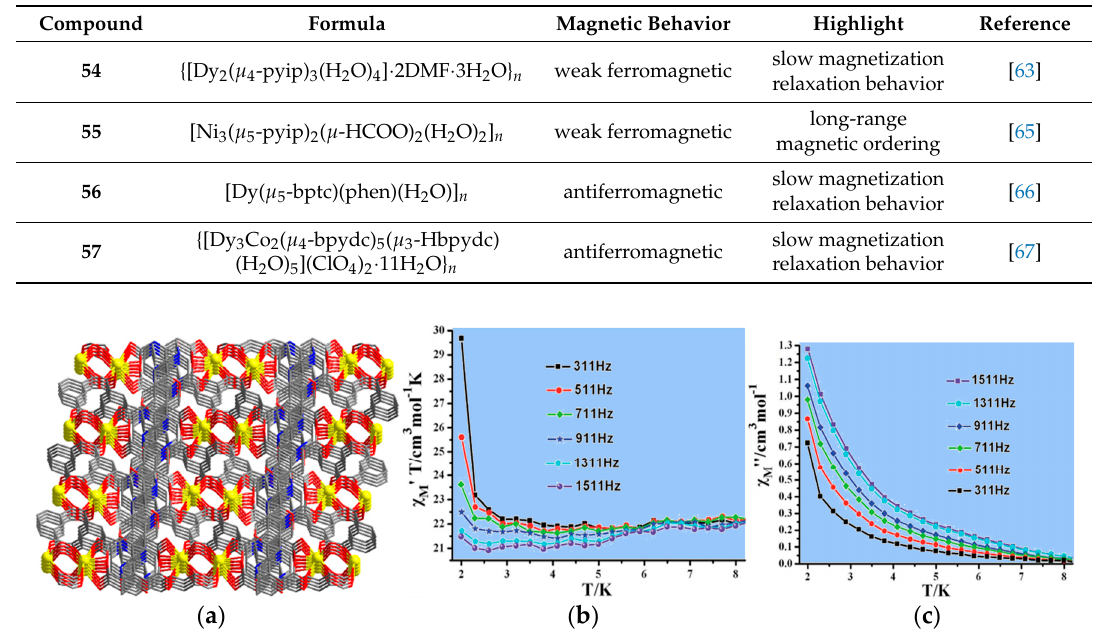
Figure 12. ( a ) 3D metal-organic framework of 54 . ( b , c ) Ac susceptibility of 54 measured in zero dc fields and plotted as χ ′ T vs. T ( b ) and χ ′′ vs. T ( c ). Adapted from [63].